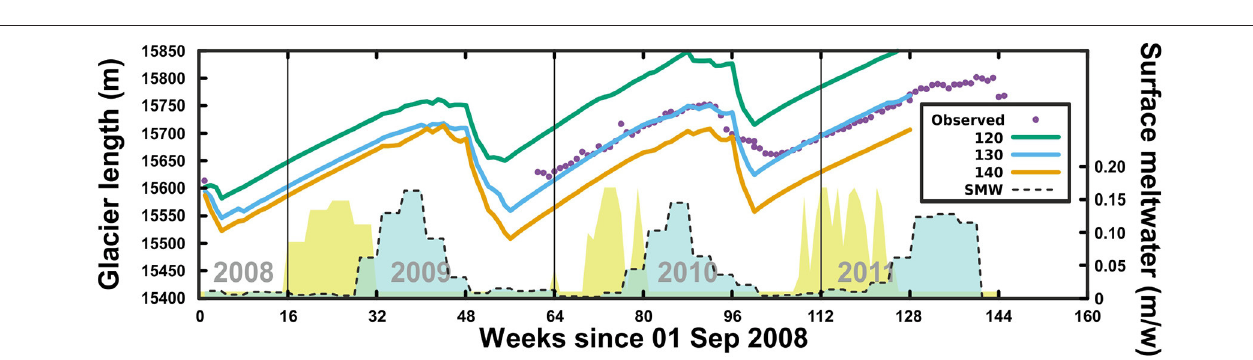
FIGURE 7 | Change in longitudinal deviatoric stress, in the terminal part of the glacier, resulting from an increase in ice mélange backstress from 0 to 50 kPa at the calving front.